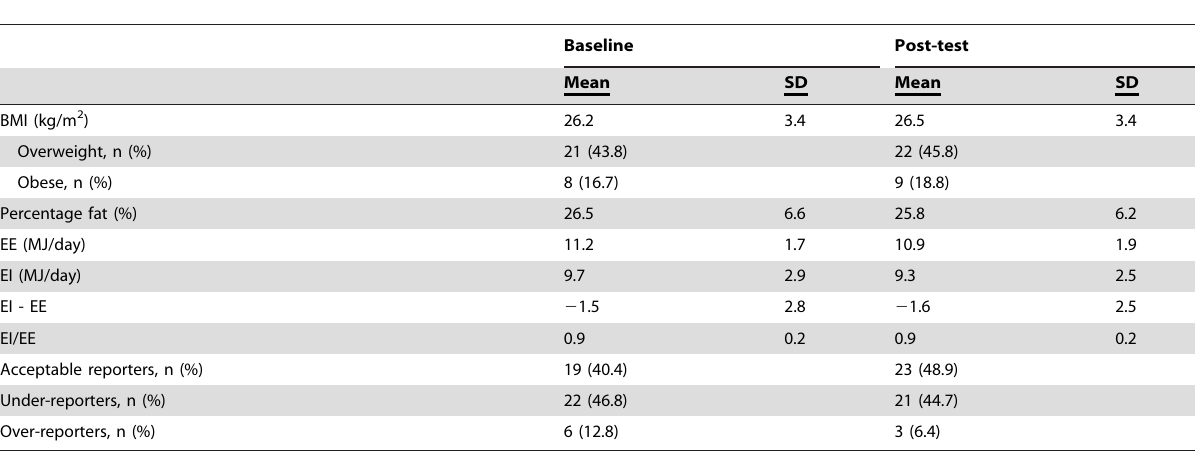
Table 1. Physical characteristics of the participants (n= 47), energy expenditure (EE) measured with SenseWear Pro 3 Armband and energy intake (EI) from the pre-coded food